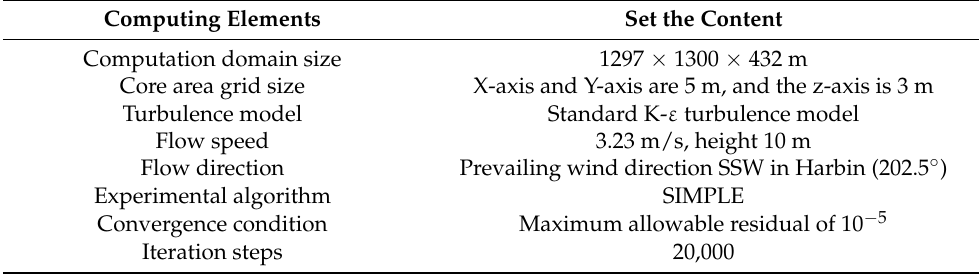
Table 1. Phoenics simulation condition